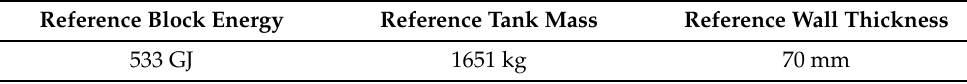
Table 7. Reference values for liquid hydrogen fuel tanks by [51].